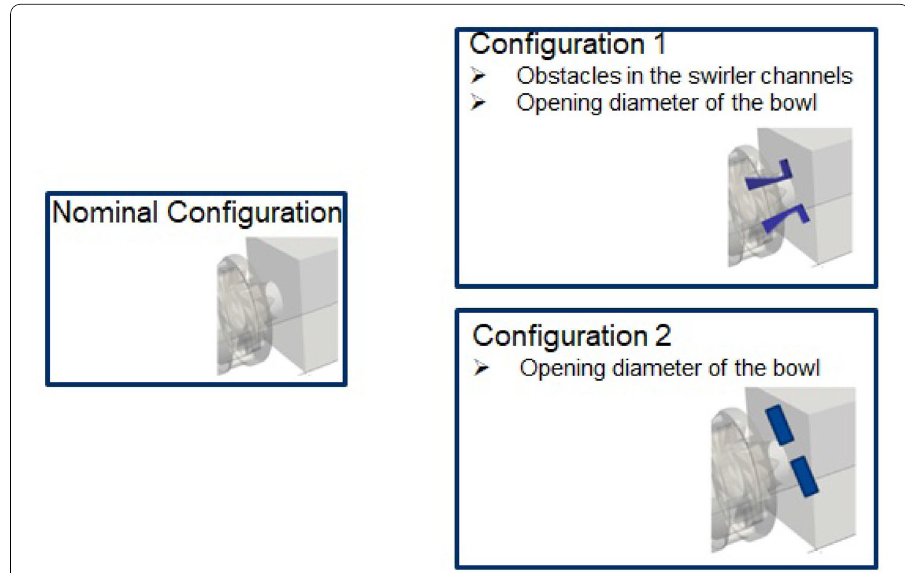
Fig. 24 Two new configurations are considered by introducing solid obstacles in the swirler’s zone. These obstacles are defined using level set functions